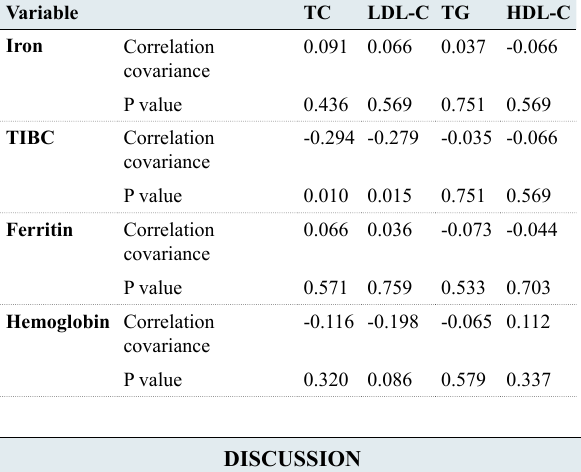
Table 3: Correlation between the lipid profile in case